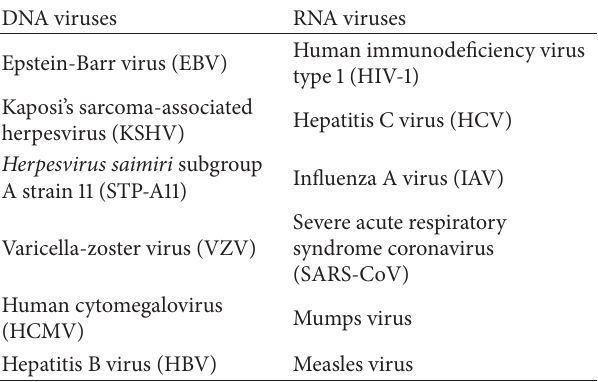
anti-inflammatory effect both in vivo and in vitro [62–64]. Table 2: Viruses that are known to regulate STAT3